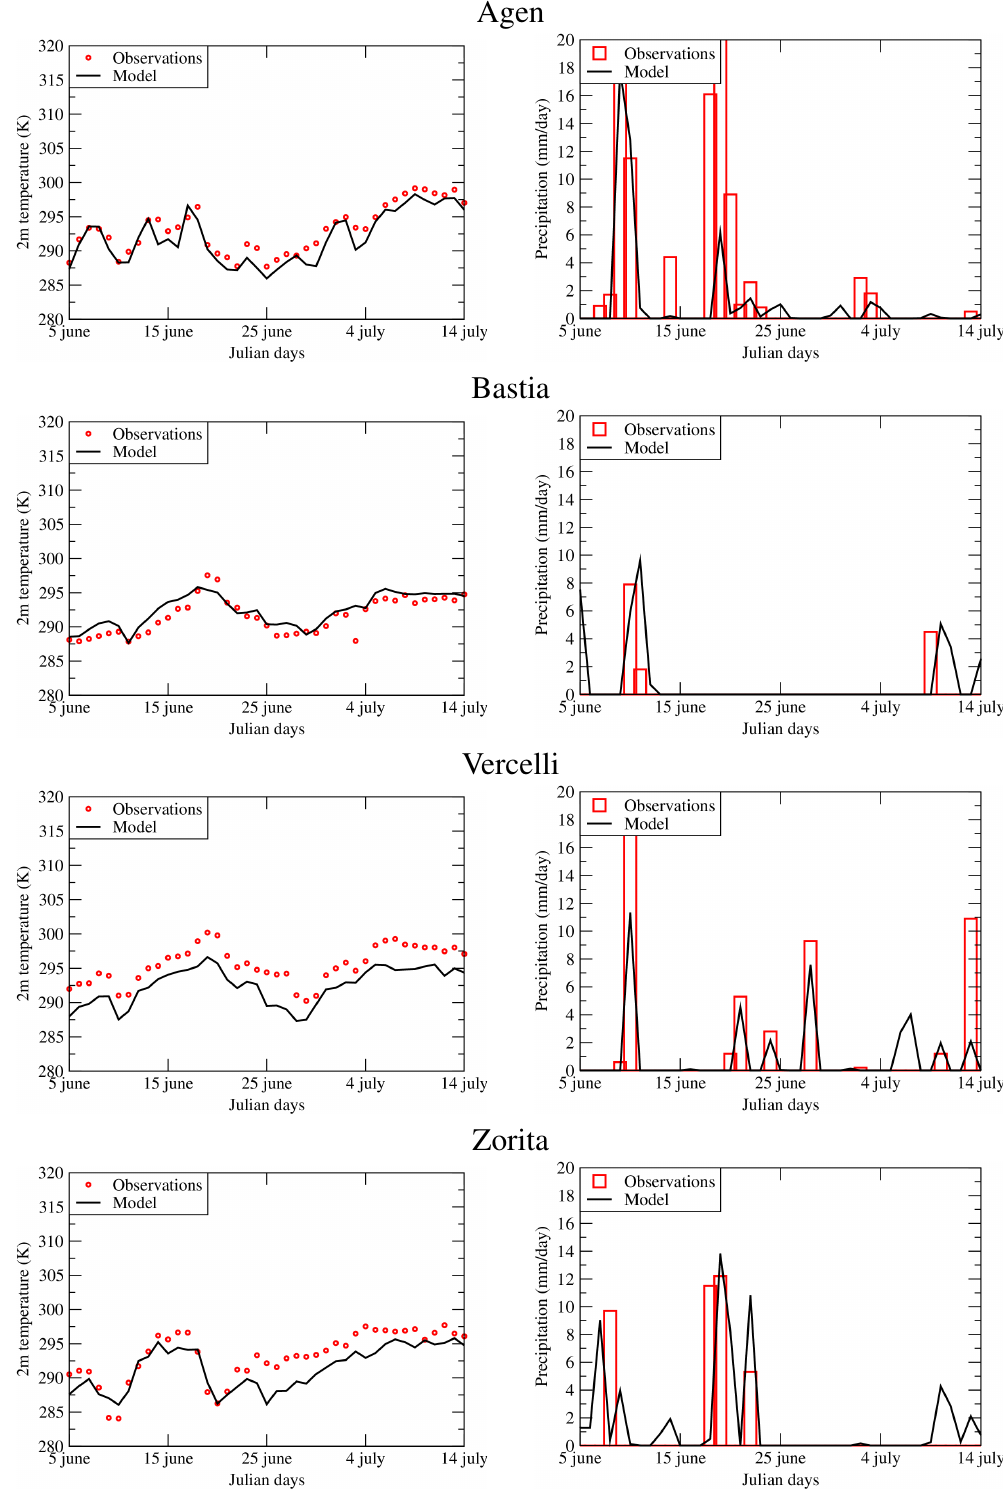
Figure 8. Time series of daily mean averaged 2m temperature (K) and daily precipitation amount (mmday − 1 ) for several sites where chemical measurements are also available. Time series are extracted from maps of E-OBS daily